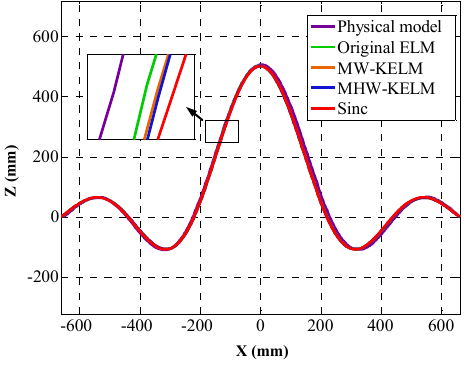
Figure 10. Calibrated Sinc.